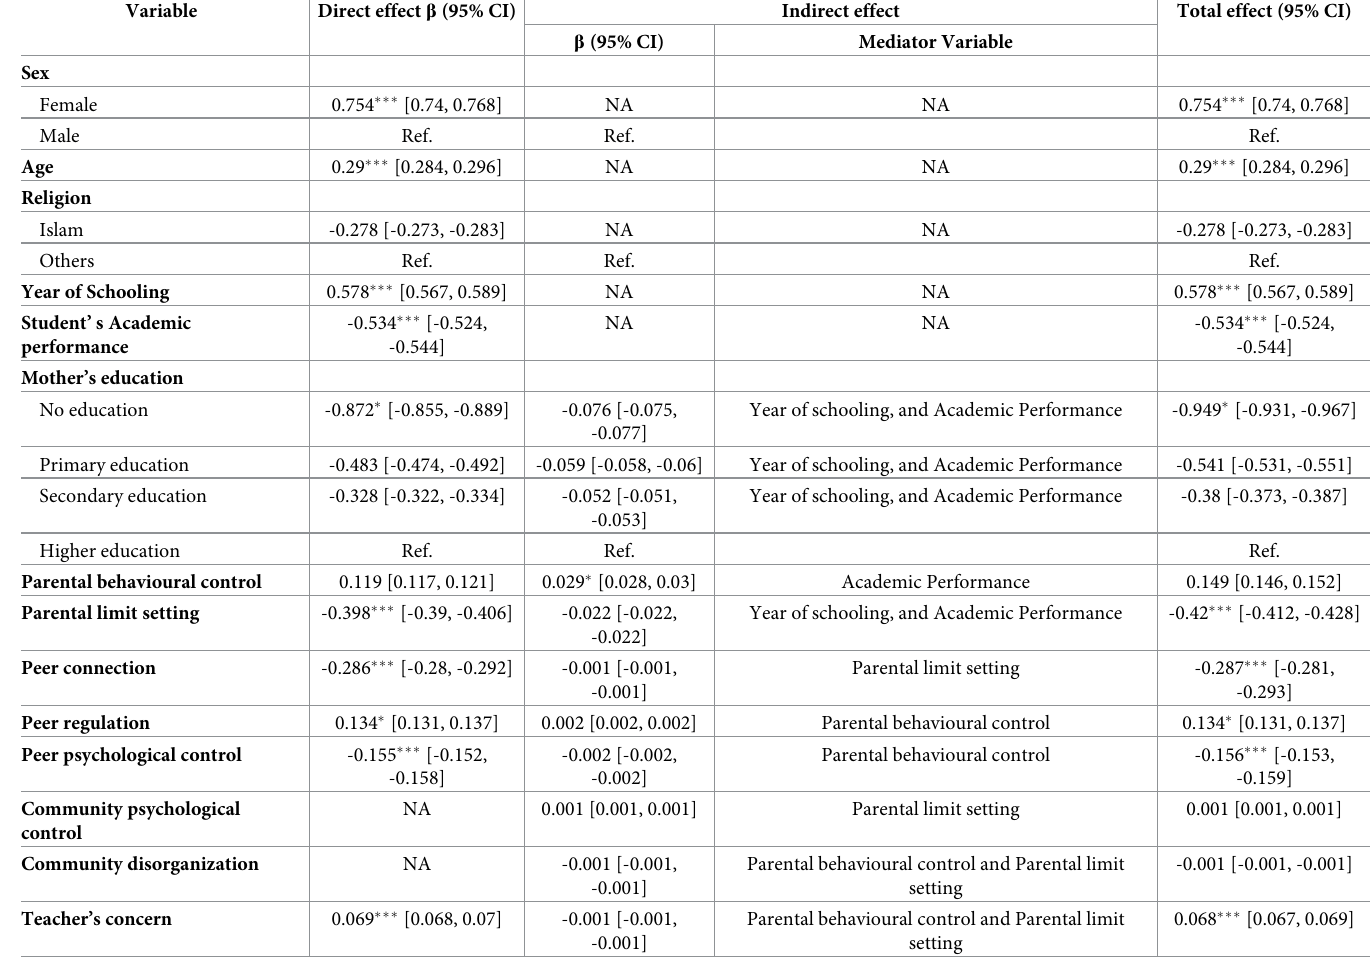
Table 4. Direct effect, indirect effect and total effect of bio-social factors on Knowledge on